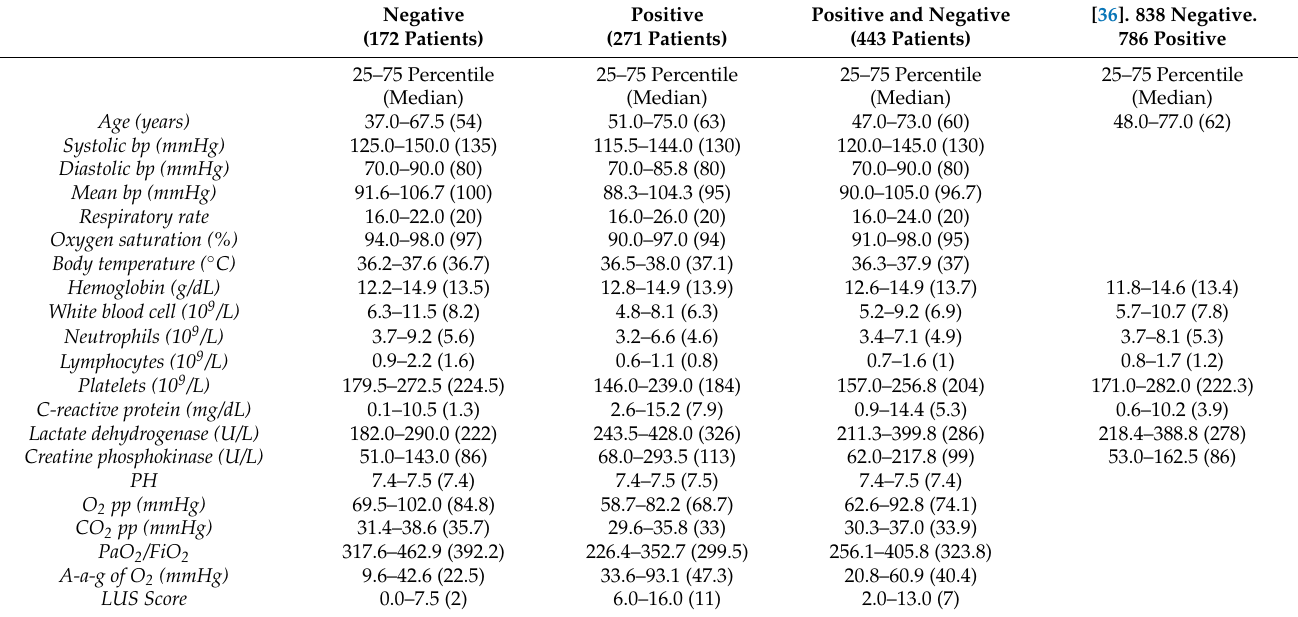
Table 1. Dataset statistics. Bp stands for blood pressure, pp means partial pressure, and A-a-g is the arterial–alveolar